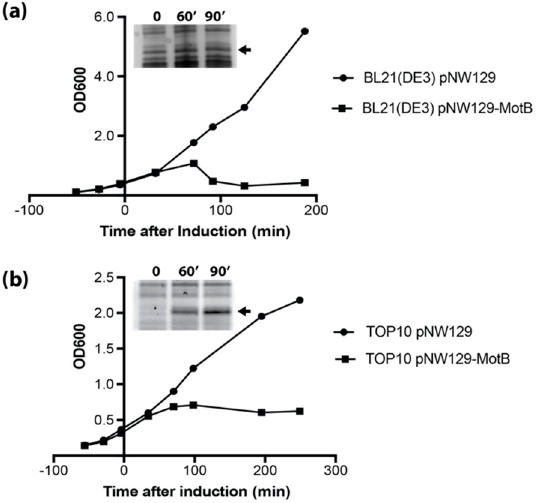
Figure 1. MotB is toxic to E. coli. Heterologous expression of motB in ( a ) BL21(DE3) or ( b ) TOP10F’ E. coli causes cell lysis or inhibits growth, respectively. Cell lines containing either the empty vector pNW129 (circles) or expression vector pNW129-MotB (squares) were induced with 0.2% ( w / v ) arabinose (final concentration) at an OD 600 between 0.3 and 0.4. Growth curves are representative of three independent replicates. To monitor the amount of MotB produced, cell aliquots at 0, 60 and 90 min post-induction were analyzed by SDS-PAGE. The protein gel slice containing MotB is shown for a representative experiment with the band corresponding to MotB designated by a black arrow. It should be noted that although MotB production is seen at 60 min for BL21(DE3)/pNW129-MotB, no additional accumulation is apparent at 90 min perhaps because of the significant cell death at this time point.